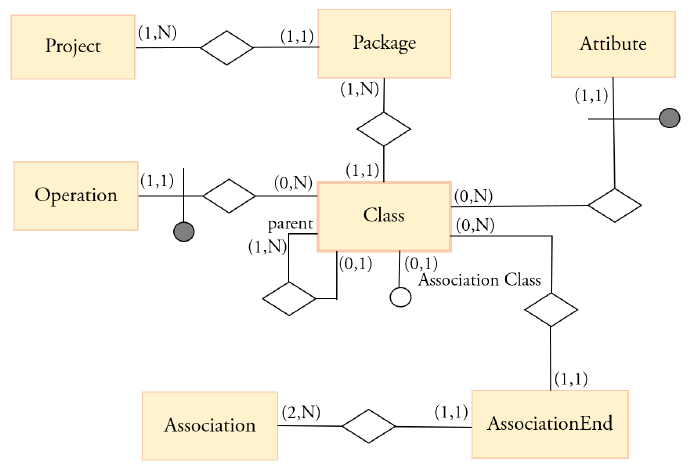
Figure 5. The E–R metaschema corresponding to the metamodel of Figure